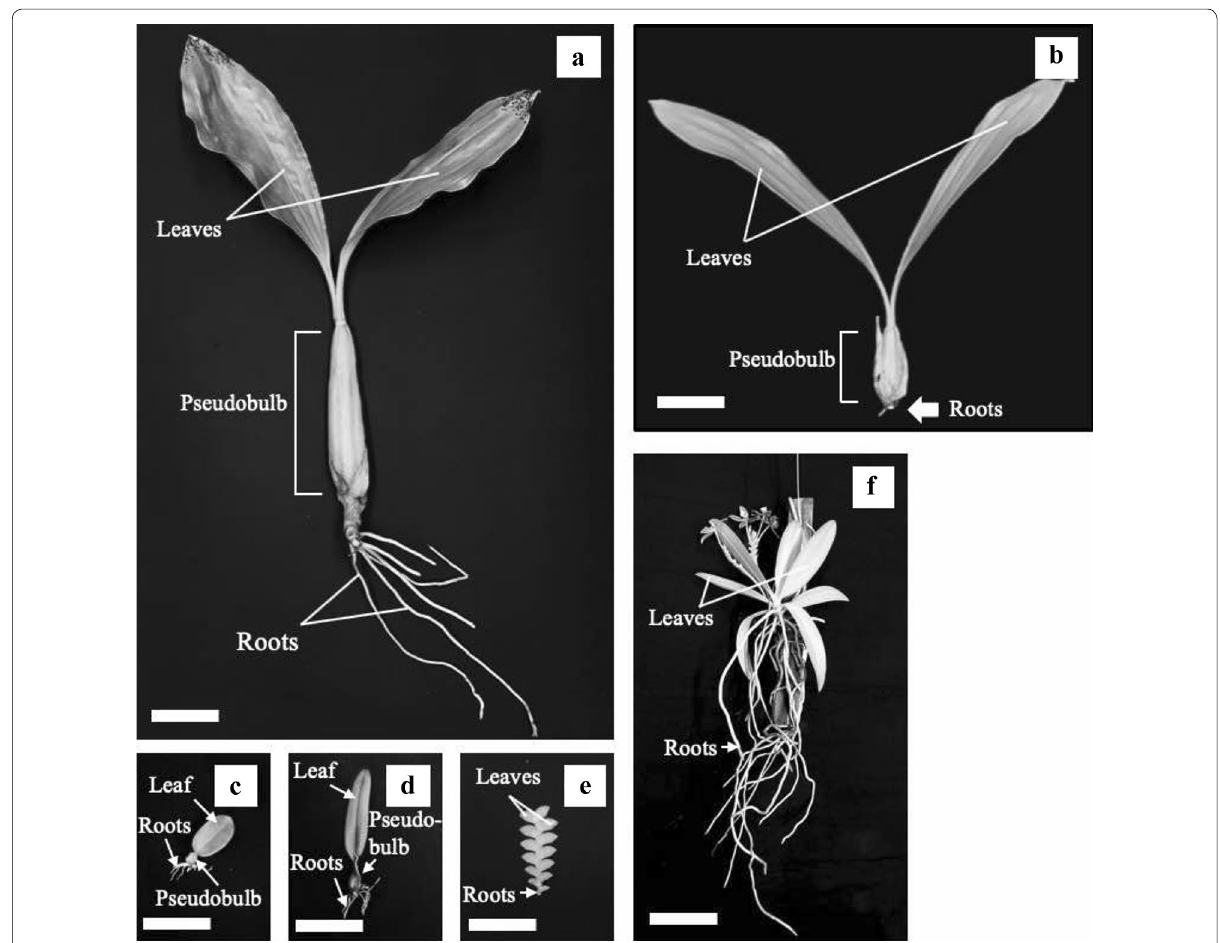
Fig. 10 Specimens of the six species studied with organs labelled: a C. rochussenii, b C. mayeriana, c B. membranaceum, d B. vaginatum, e D. leonis, f P. cornu - cervi . White bar at the bottom-left corner of each specimen image represents 5